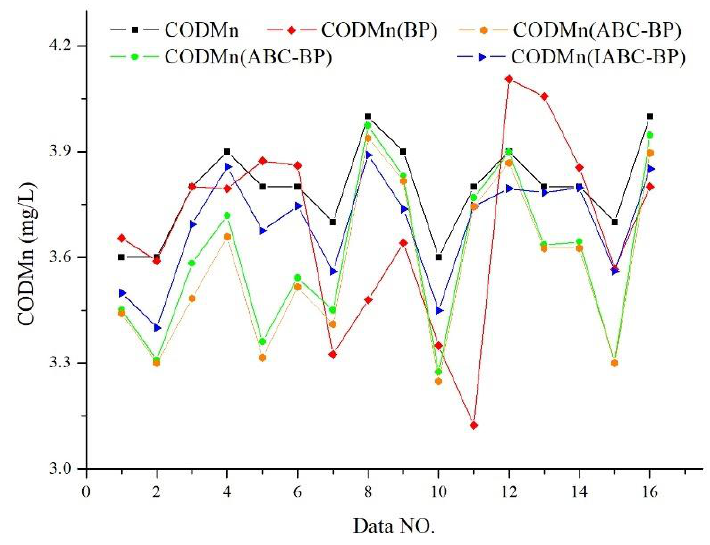
Figure 9. Comparison of COD Mn among the four models.